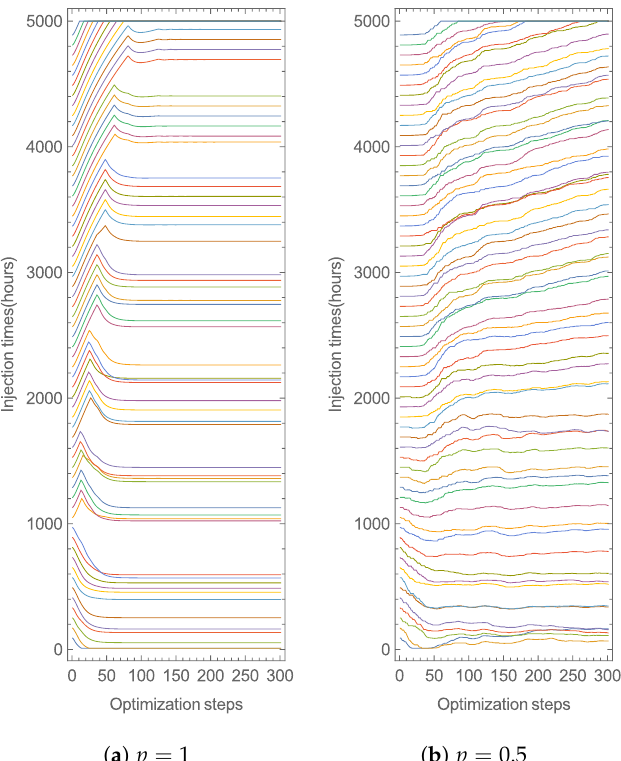
Figure 7. Panel ( a ), the deterministic case, considers Algorithm 1 using p = 1. Panel ( b ) shows the stochastic case using p = 0.5, so, at each optimization step, the algorithm picks 50% of the injection times from the schedule to update. The deterministic case progresses to well-marked schedules. The stochastic version produces a more scattered schedule than the